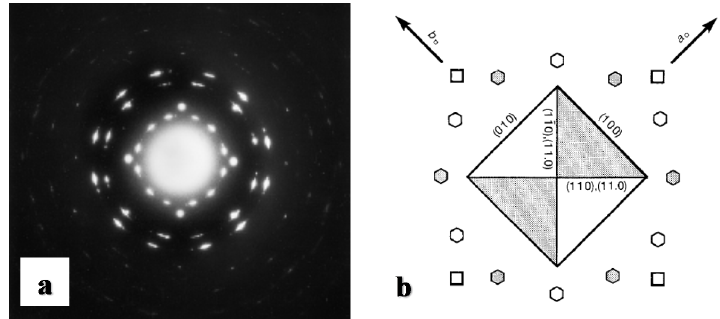
Figure 21. BF electron micrograph and its corresponding electron diffraction patterns (insets) of an oriented iPBu thin film taken during the II-I phase transition. The electron diffraction patterns in the lower left and lower right corners correspond to the form II and form I crystals, respectively. Reproduced with permission from Ref. [90], copyright 2003 American Chemical Society.